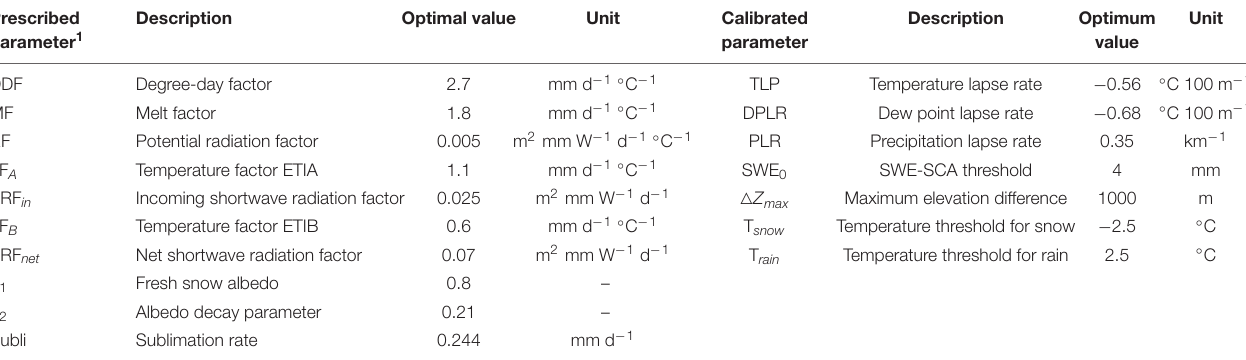
TABLE 3 | Summary of prescribed and calibrated model parameters. Prescribed parameter 1